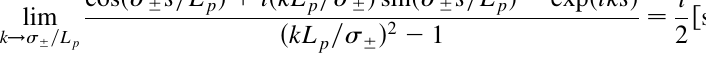
=" (cid:5) c %"%" 0 =" (cid:4) = 2 > 0 x y